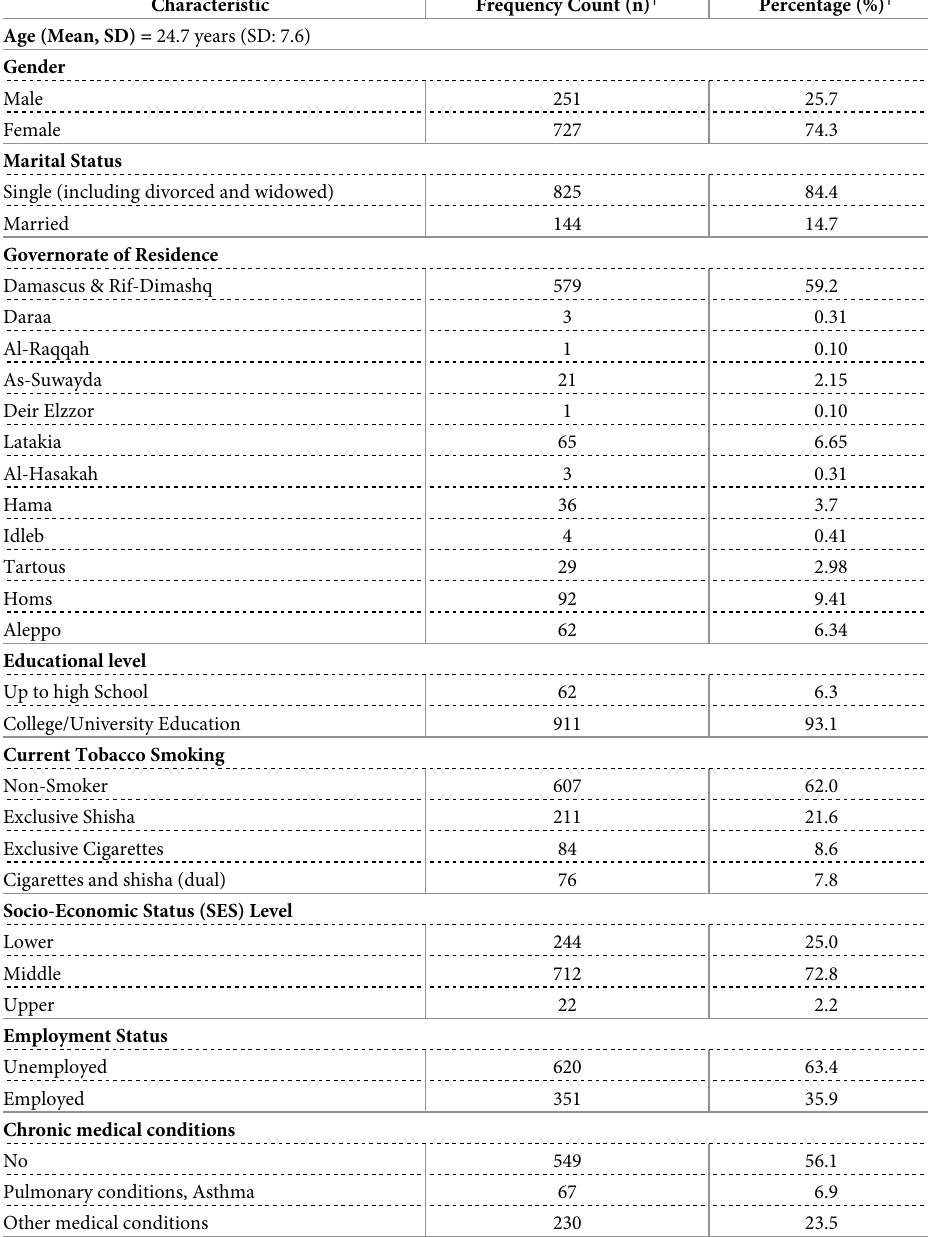
Table 1. Socio-demographic characteristics of the respondents (n = 978).